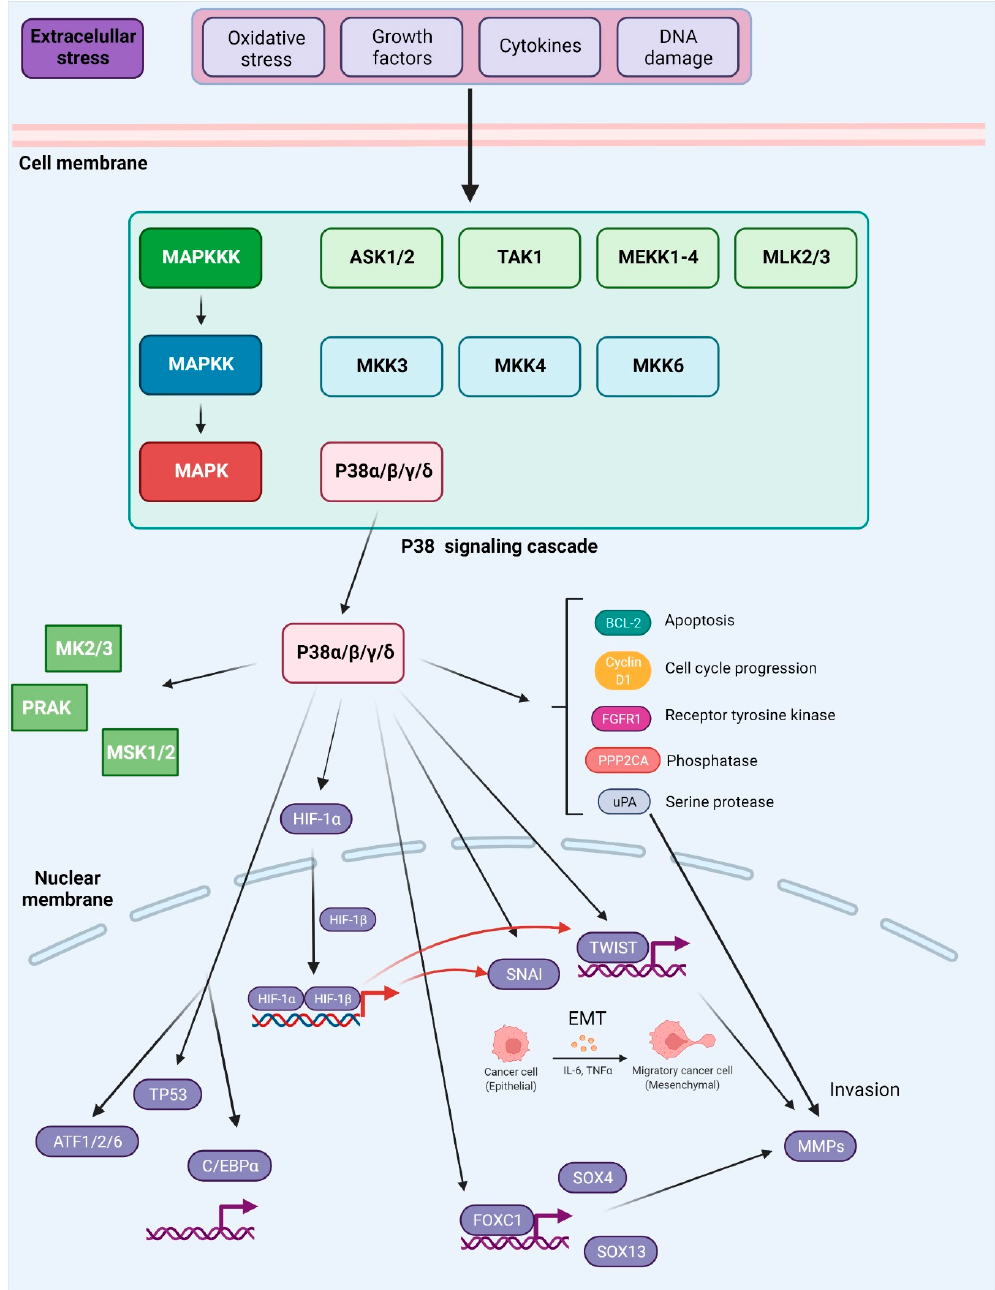
Figure 5. Activation and downstream targets of P38 MAPK. P38 MAPK is activated through several mechanisms. The canonical MAPK signaling module involves sequential phosphorylation and ac- tivation events that pass down from MAP3Ks to MAP2Ks, and from MAP2Ks to P38 MAPK. In